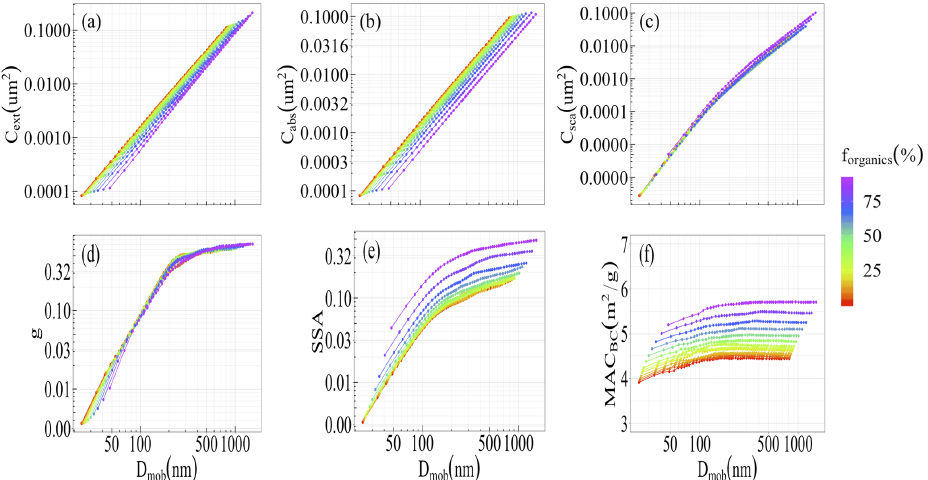
Figure 7. Optical properties of BCFAs ( D f = 1.7) as a function of D mob at various fractions of organics ( f organics ): (a) extinction cross section C ext , (b) absorption cross section C abs , (c) scattering cross section C sca , (d) asymmetry parameter g , (e) single-scattering albedo (SSA), and (f) black carbon mass absorption cross section MAC BC at λ = 660nm.